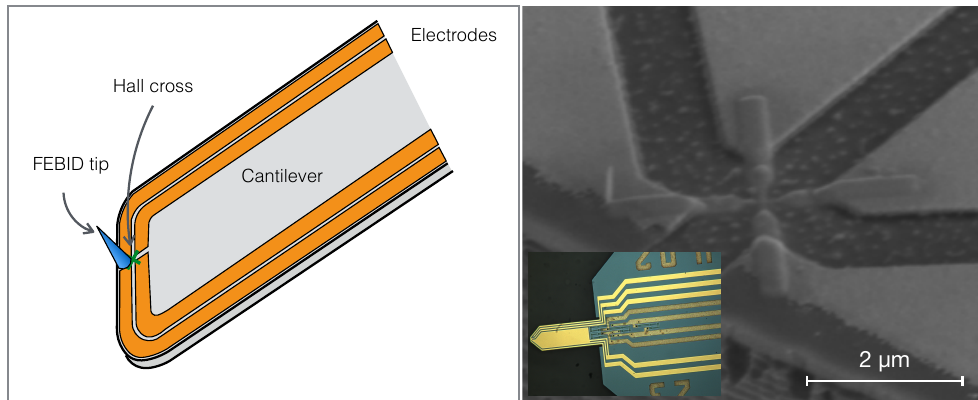
Figure 5. ( Left ): Schematic front edge of self-sensing cantilever with pre-fabricated Cr/Au electrodes between which a GFM Hall sensor cross has been written by FEBID, as well as a non-magnetic tip for complementary atomic force microscopy. ( Right ): SEM image of GFM Hall cross between Cr/Au electrodes. The Hall cross has an effective sensing area of 50 × 50nm 2 . Inset: Optical microscopy image of self-sensing cantilever with cantilever